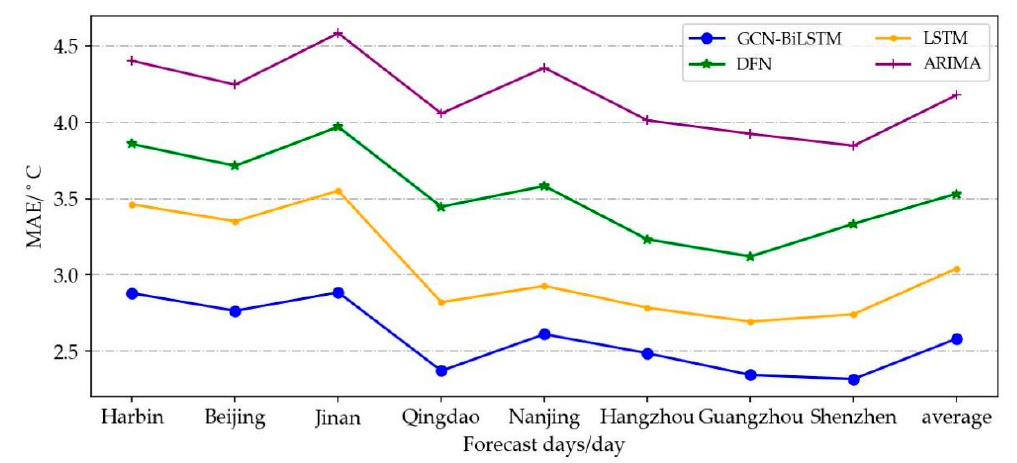
Figure 10. Comparison of MAE in multiregional temperature prediction experiments.